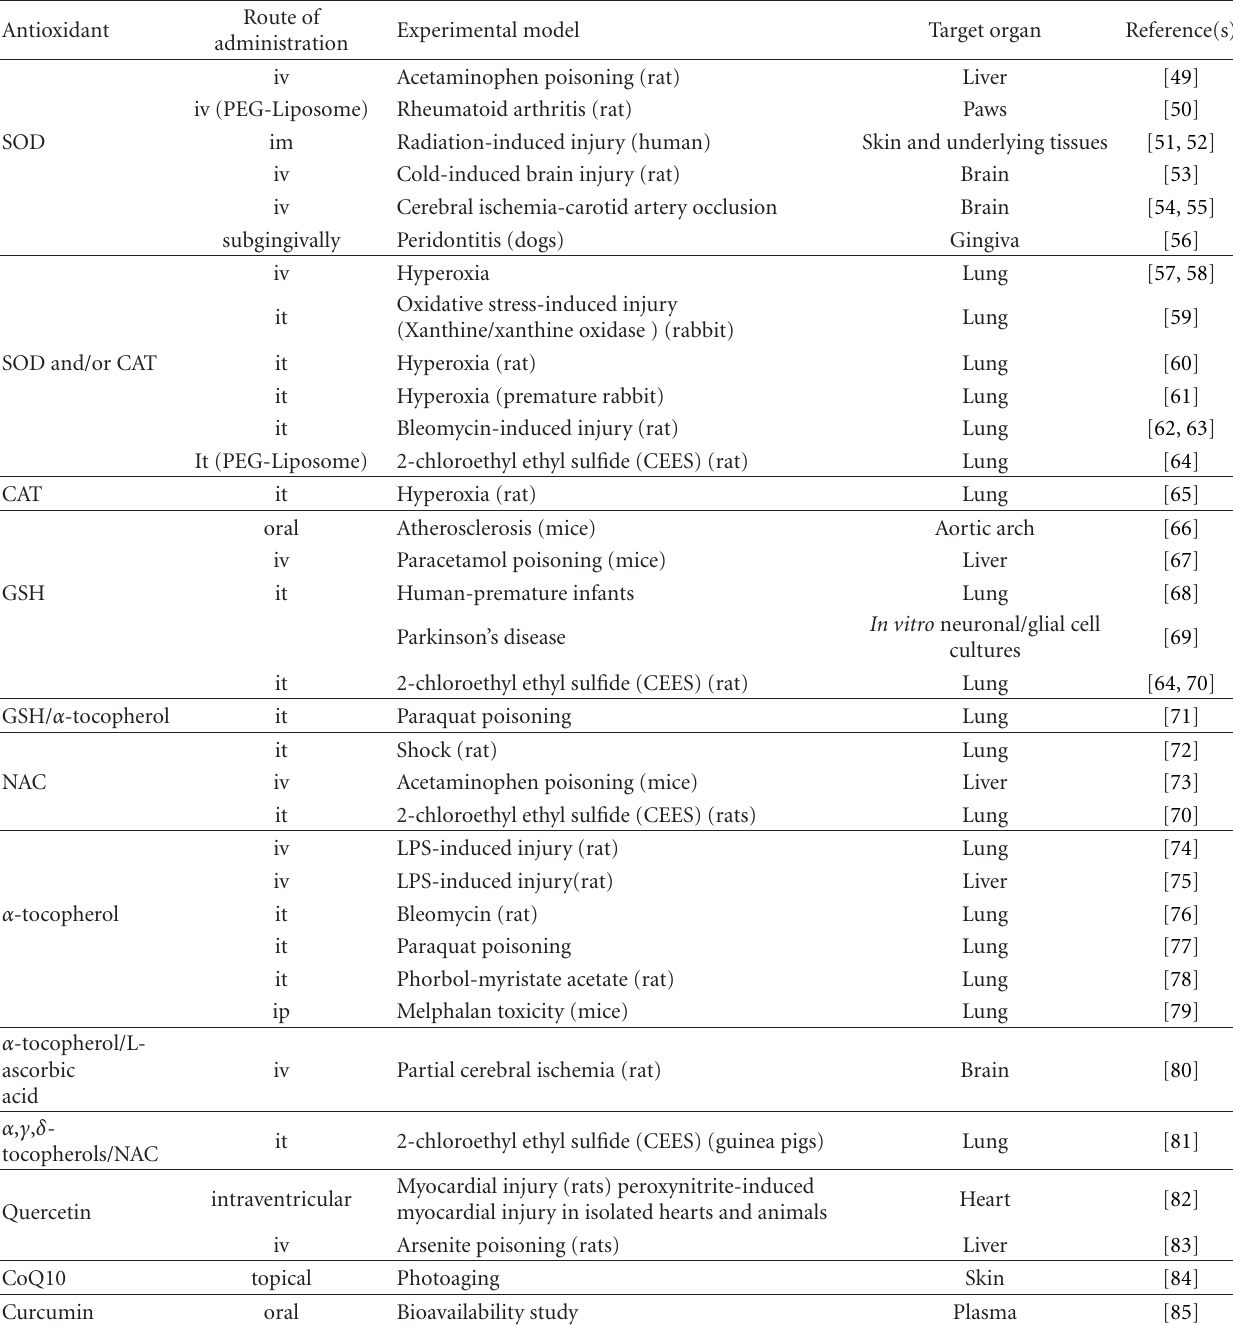
Table 1: Antioxidants delivered as liposomal formulations in animal models of oxidative stress.